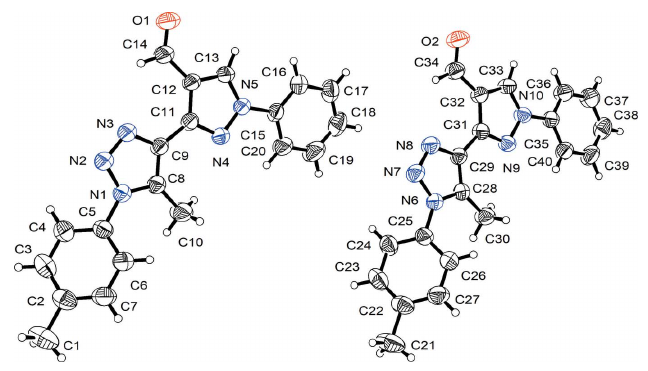
Figure 1 The molecular structure of the title compound showing 50% displace- ment